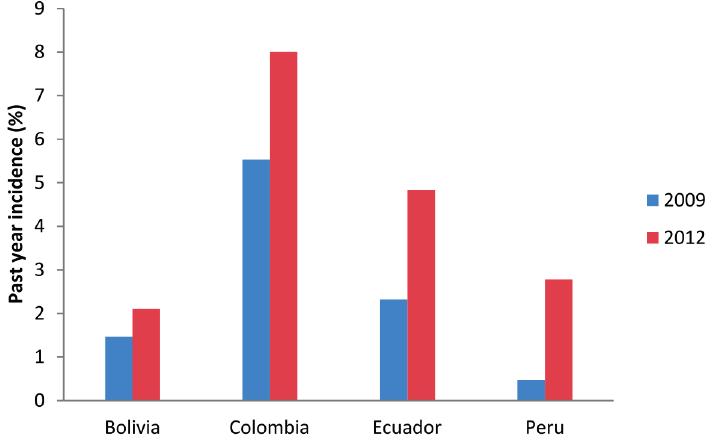
Figure 1. Past year incidence of marijuana use in Andean Countries, by